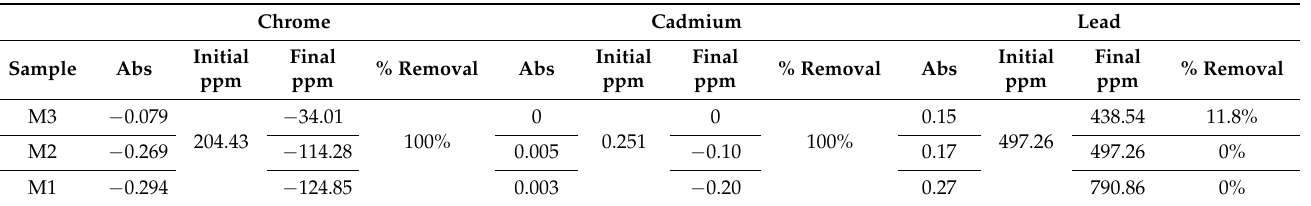
Table 1. Quantification of the removal of heavy metals present in agricultural soil through the application of FeO